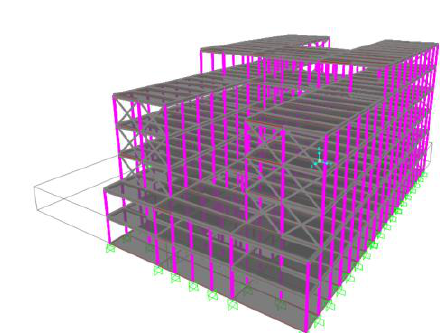
Figure 9. Traditional model of the educational building designed in SAP2000.